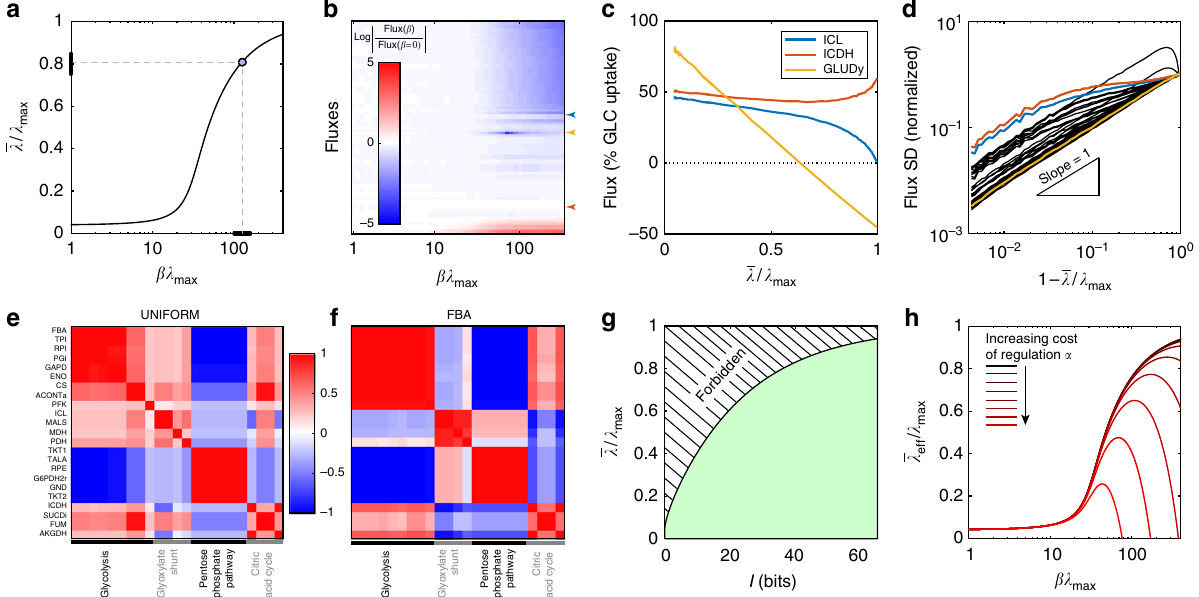
Fig. 3 a Average growth rate (relative to maximal achievable rate) as a function of βλ max . Inferred value for data in Fig. 2a is shown as a blue point (thick black line = STD for (cid:1) λ = λ and the corresponding range for βλ max ). b Log fold change of average fl uxes as a function of βλ max , relative to the uniform max distribution; fl uxes are sorted by their change in the FBA ( β → ∞ ) limit. c Dependence of three selected fl uxes (legend, highlighted with correspondingly colored arrows in b ) on the average growth rate, (cid:1) λ : ICL is turned off in the FBA limit (but not in the maximum entropy solution), ICDH remains nearly unchanged with (cid:1) λ , and GLUDy is the only fl ux that switches sign. d Flux variabilities (each black line = SD of one fl ux according to maximum entropy distribution, three selected fl uxes from c highlighted in color) scale linearly with distance to maximal growth rate and vanish in the FBA limit. e , f Correlation coef fi cient matrix (Pearson correlation, color scale) between 23 selected fl uxes in the uniform ( e ) and FBA ( f ) limits, computed within maximum entropy framework. Fluxes have been grouped into four clusters according to the correlation in the FBA limit and reordered accordingly in both plots; clusters are strongly enriched for fl uxes belonging to pathways denoted at bottom. Note the fl ip in correlation sign between the glycolysis and glyoxylate shunt pathways between the two limits. g Achieving a particular growth rate ( y -axis) requires reducing the entropy of the joint distribution of fl uxes at least by I bits below the entropy of the uniform distribution (green region). Points in the hashed (forbidden) region are not achievable. h A simple model in which tight regulation of fl uxes (higher I ) enables higher growth rates, as in g , but also entails metabolic cost (see text). For a given cost α ,